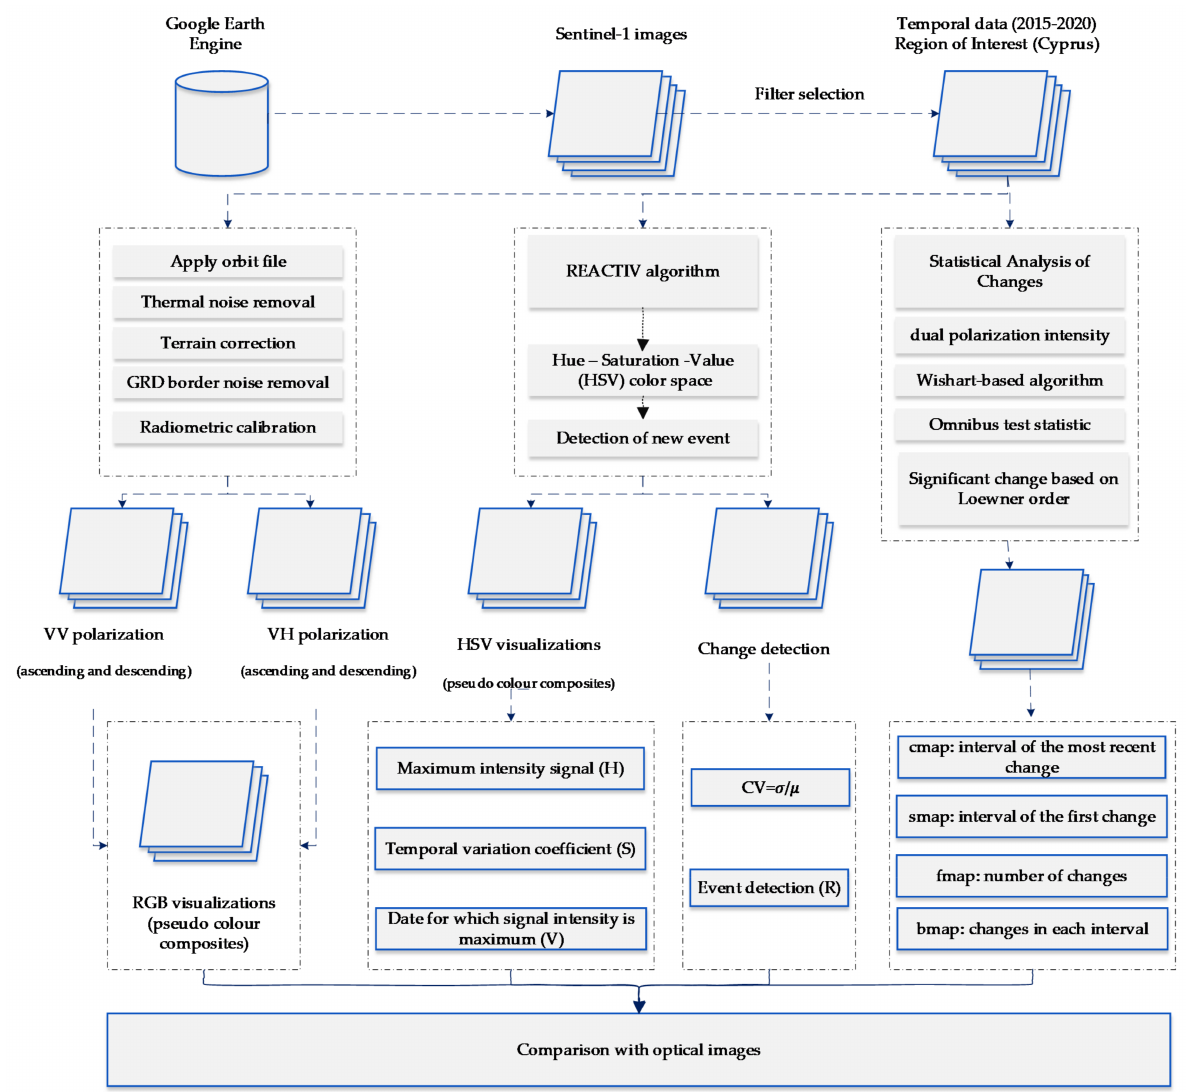
Figure 3. The overall methodology implemented in the current study, where: REACTIV corresponds to the “Rapid and Easy Change Detection in Radar Time-Series by Variation Coefficient” algorithm, VV to the “vertical transmit, vertical receive polarisation, VH to the “vertical transmit, horizontal receive polarisation”, GRD to the “Ground Range Detected” and CV to the “coefficient